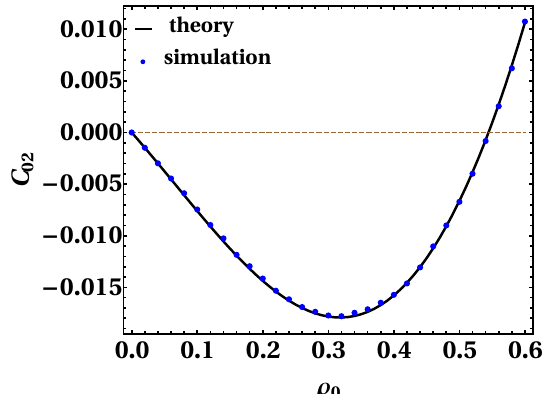
Figure 7: The figure shows a crossover from negative correlation to positive corre- lation for C (between vacancy and species 2) with increasing vacancy density ρ . 02 0 There is some special intermediate density for which C becomes zero. The param- 02 = 0.3, p = 1.0, ε = 0.1, w = 0.8, w = 1.0, ρ = 0.2. eters used are L = 10 3 , p + 1 2 12 21 The ensemble average is done over 10 5